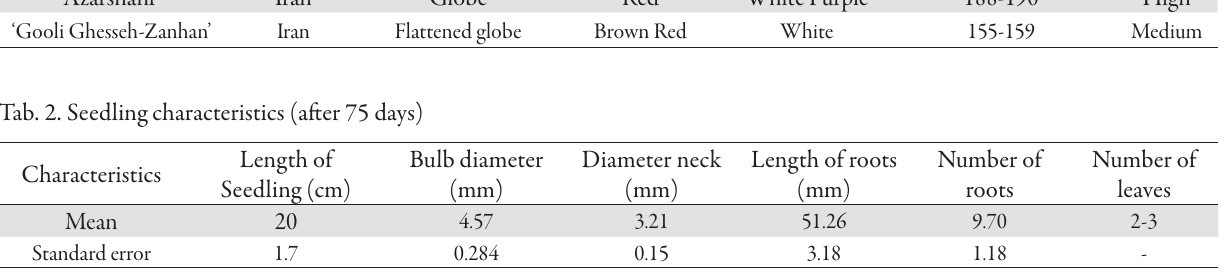
Tab. 1. Characteristics of onion cultivars used Cultivars quality